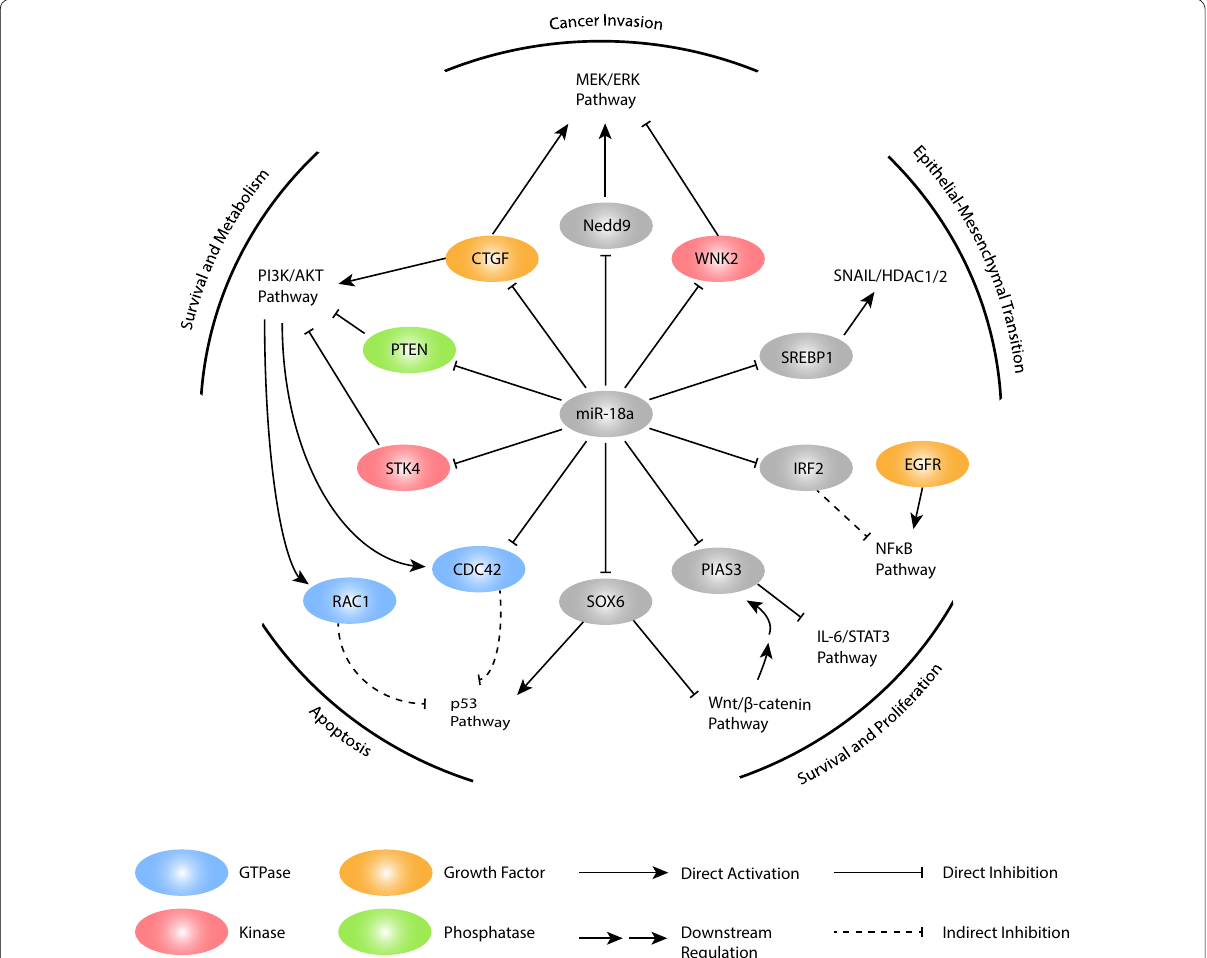
Fig. 3 Signal transduction of miR-18a, with direct targets and associated pathways. The mechanisms of miR-18a regulation are characterized by direct activation or inhibition of the factors involved in signaling pathways that either promote or suppress cancer